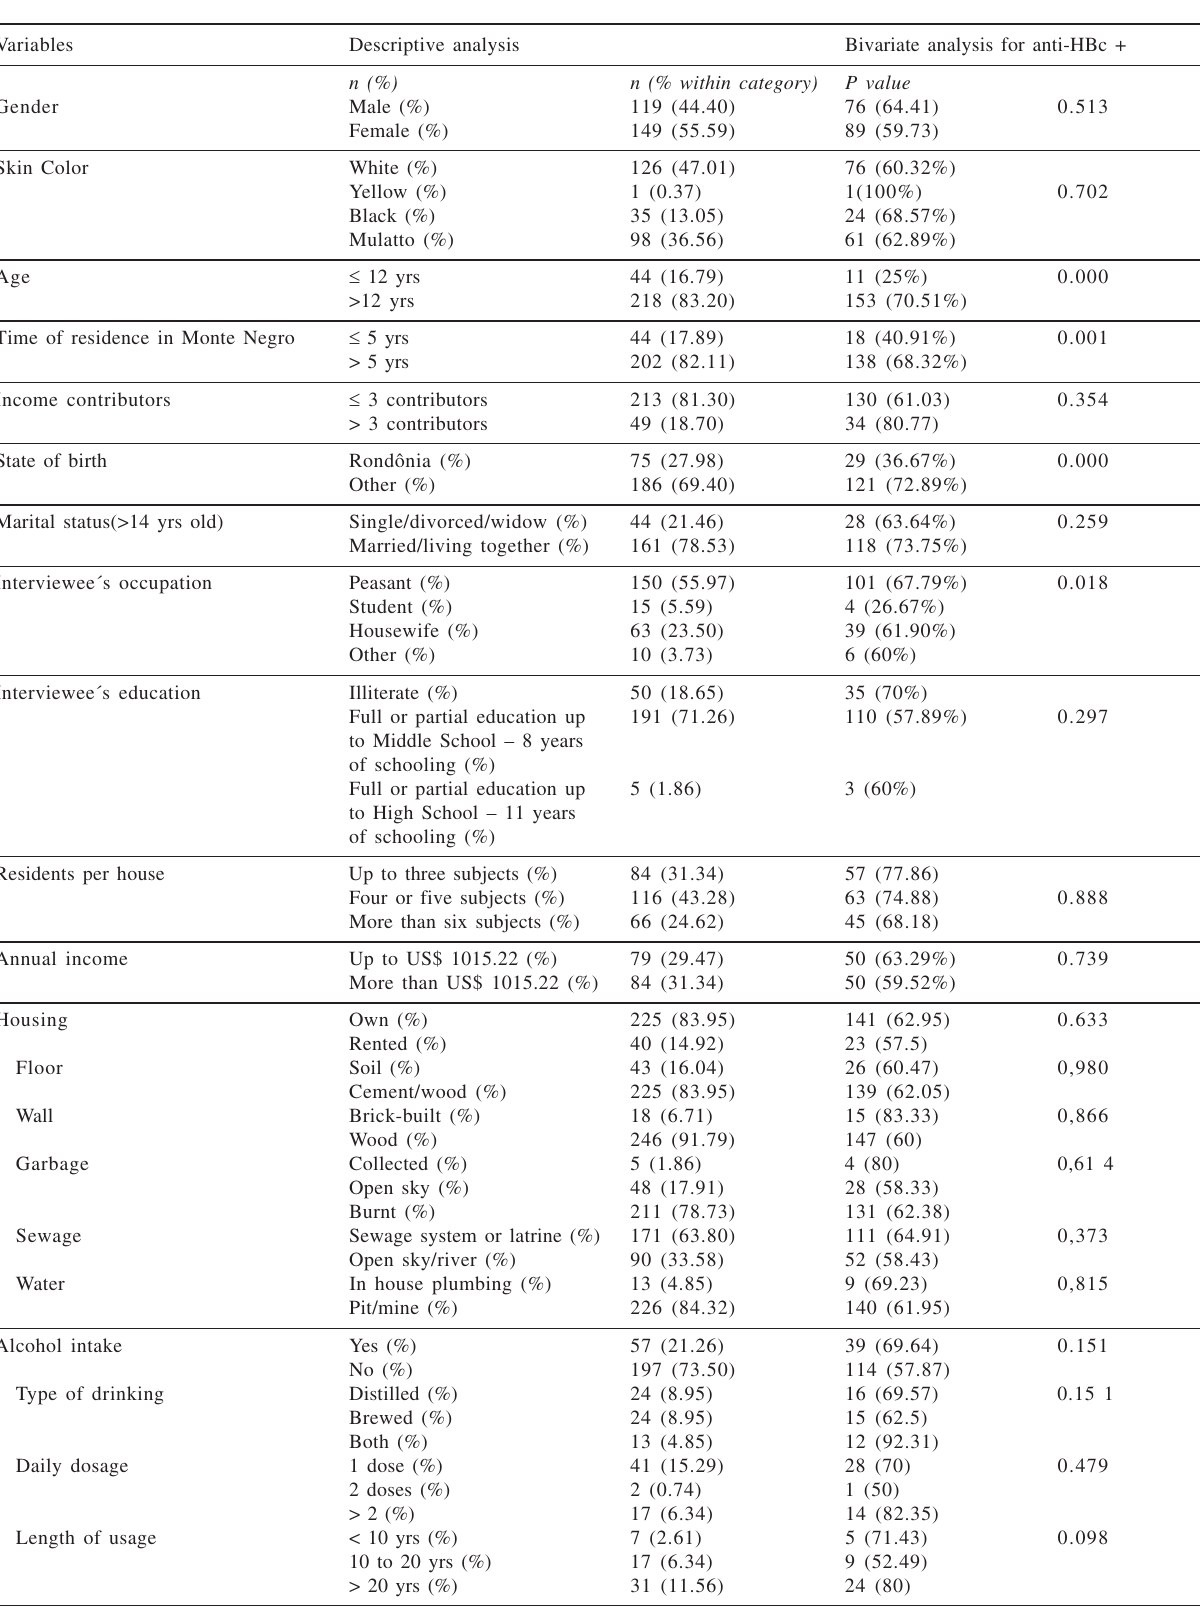
Table 4 - Descriptive and Bivariate analysis for Anti-HBc positive